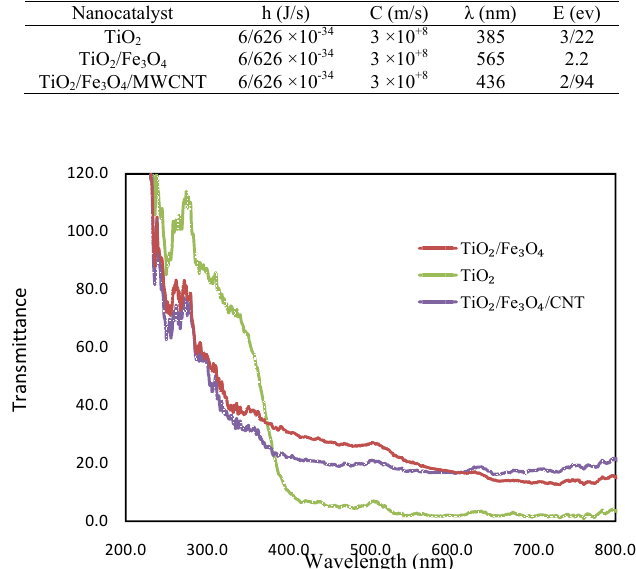
, TiO /Fe O and TiO 2 2 3 4